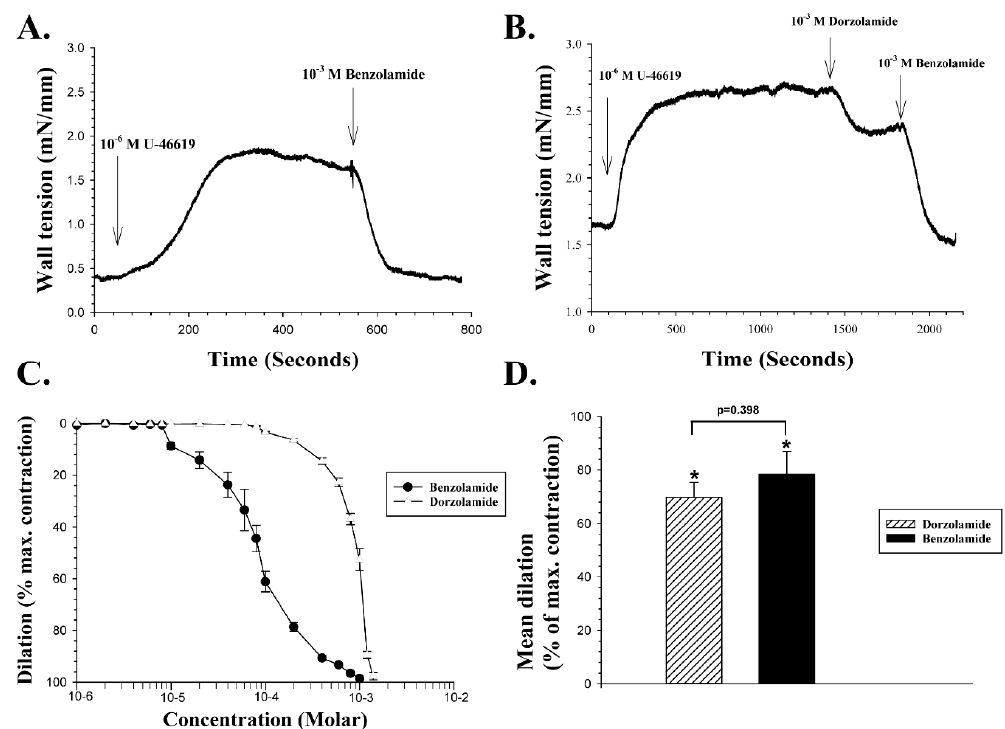
Figure 2. The effects of U-46619, BZA and DZA on wall tension in porcine retinal arteries. A : Continuous myography recording of wall tension in one artery. The vertical arrow on the left indicates the time point when 10 − 6 M U-46619 was added to the bath. The wall tension then increases and reaches a peak, and 10 − 3 M BZA was added at the time indicated by the right vertical arrow. Note the rapid vasodilation induced by BZA to the baseline level. B : Myography recording from another artery. After vasoconstriction induced by U-46619 reached a peak, 10 − 3 M DZA was added at the time indicated by the middle arrow. The left vertical arrow indicates an addition of 10 − 3 M BZA. Note the additional dilation induced by BZA. C : Mean concentration-response curves for the dilatory effects of BZA (filled circles) and a (open triangles), expressed as a percentage of the maximum contraction induced by U-46619. Symbols represent the mean ± standard error of the mean (SEM) dilation at each concentration. D: The mean ± SEM dilation induced by BZA and DZA in response to a single dose of 10 − 3 M added to the bathing solution, as a percentage of the maximum contraction induced by U-46619. An asterix (*) above bars indicates statistically significant vasodilation (p < 0.002)